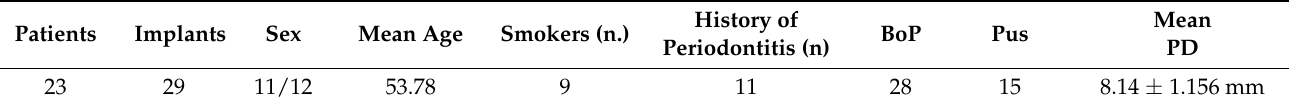
Table 1. Baseline values.